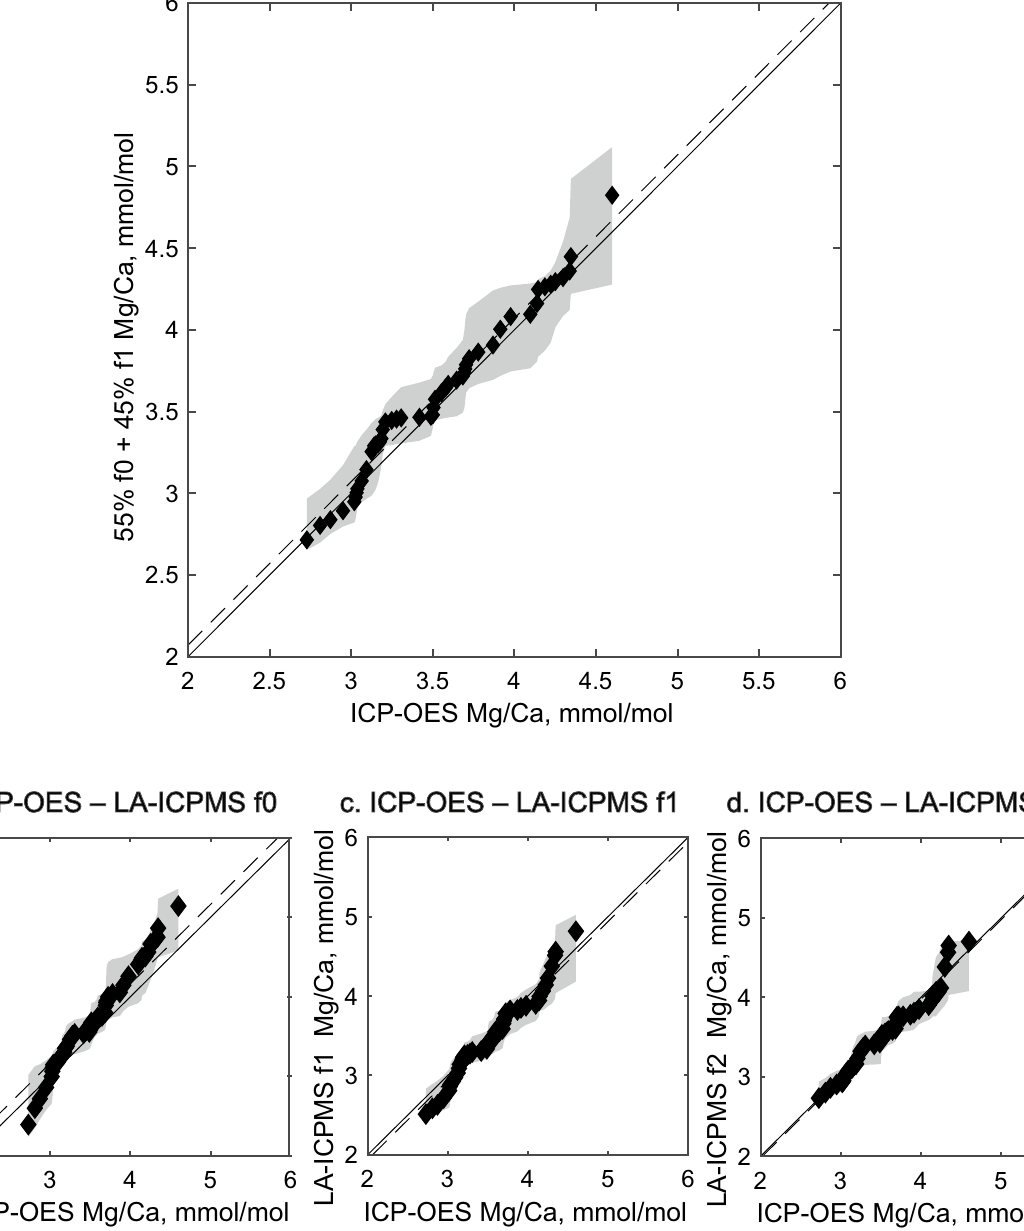
Figure 7. Quantile–quantile analysis of ICP-OES Mg/Ca and LA-ICPMS Mg/Ca. The population distribution of Mg/Ca values from ICP-OES is identical to the Mg/Ca values obtained using LA-ICPMS and the 55% f0 + 45% f1 weighted average maximal correlation, shown in ( a ). ( b ) The same analysis using LA-ICPMS Mg/Ca from the f0 chamber only. ( c ) The same analysis with only the f1 chamber, and ( d ) same analysis with only the f2 chamber. In all cases, the ICP-OES Mg/Ca and LA-ICPMS Mg/Ca distributions are highly